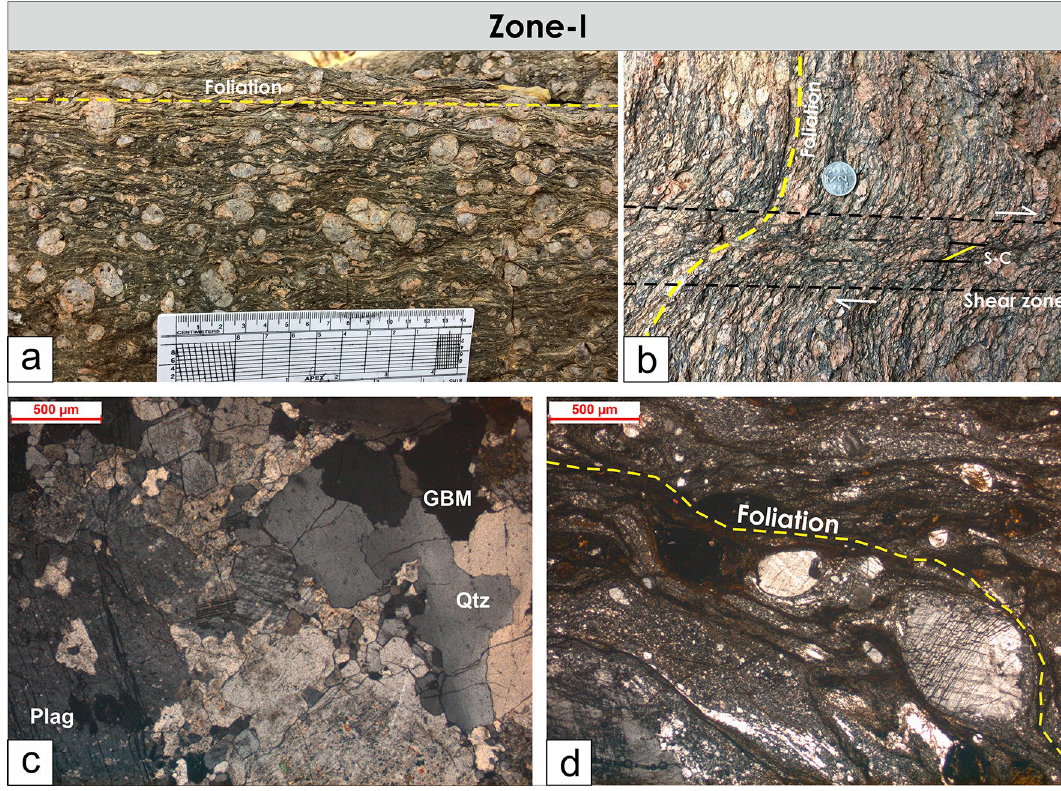
Figure 6. Field photographs and photomicrographs of structures from Zone-I. ( a ) Granite mylonite with mylonitic foliations and rotated feldspar porphyroclasts, ( b ) A localized shear zone with S-C fabrics crosscut the mylonitic foliations, ( c ) Photomicrograph of the granite mylonite with crystal plastic deformation (Grain Boundary Migration, GBM) in quartz and feldspar, ( d ) Photomicrograph of mylonite with typical core-mantle structures in